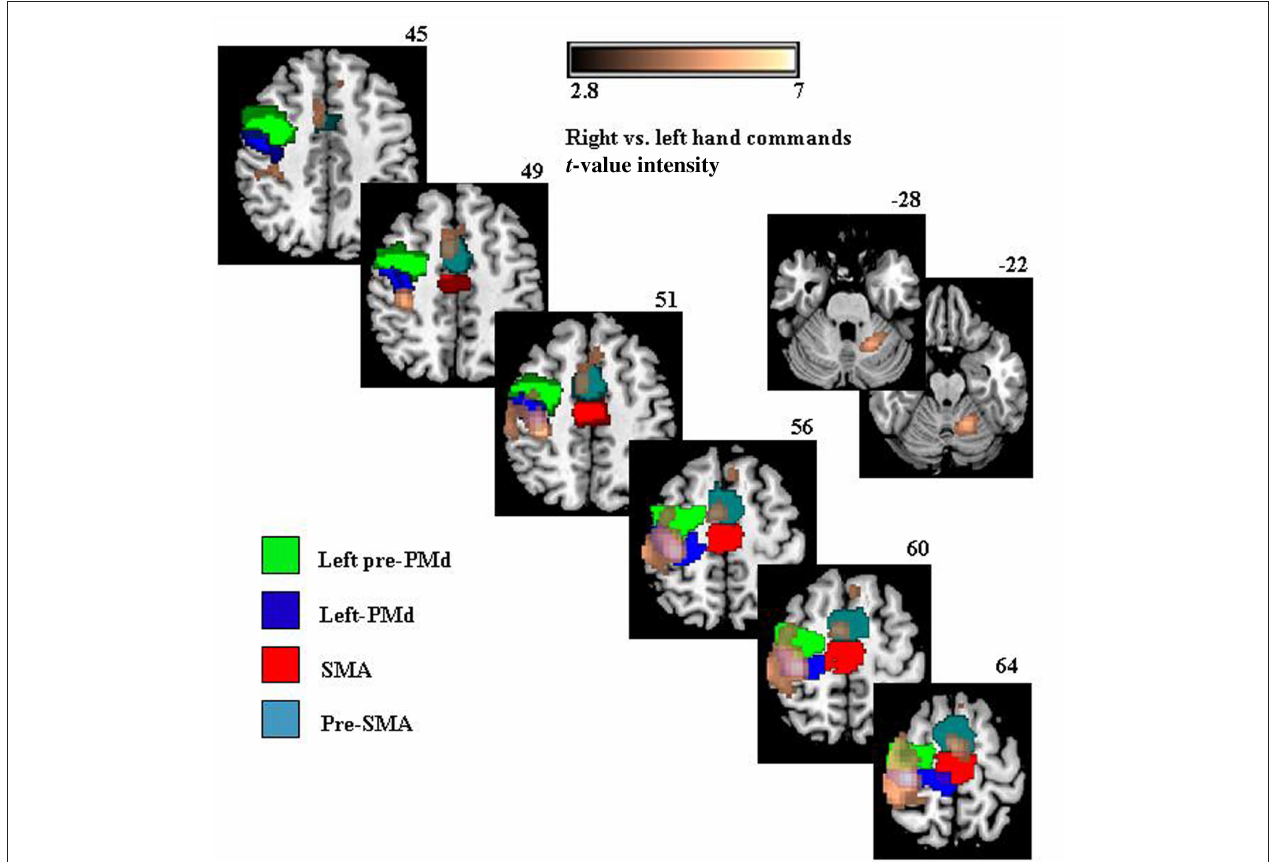
Figure A1 | Command induced activity in premotor cortex in healthy volunteers. Activity (in brown) corresponds to the results for the right vs. left-hand command contrast for each of the three control subjects (single subject